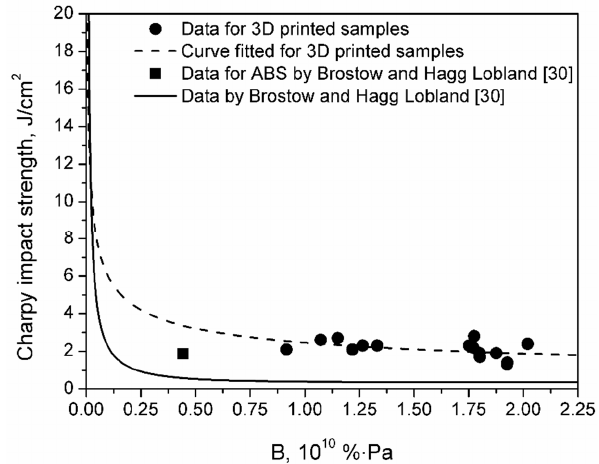
Figure 6. Relationship between Charpy impact strength and brittleness for analyzed materials and comparison with literature data. comparison with literature